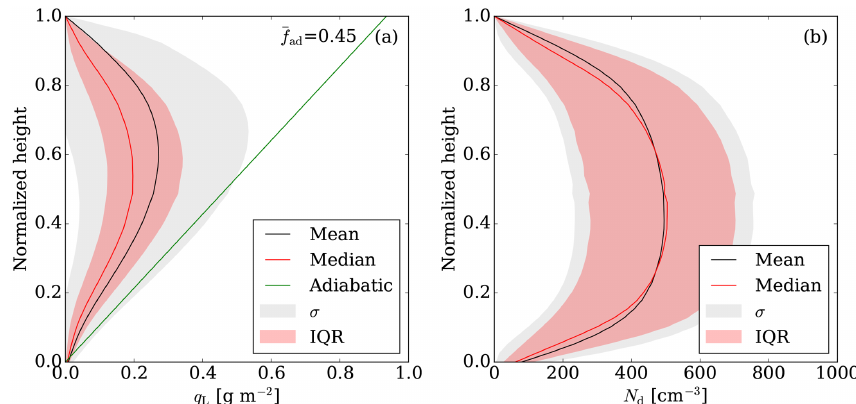
Figure 3. ICON-LEM simulated mean (a) q L and (b) N d profiles for all the case days on average. Profiles are normalized over height from the CBH to the CTH. Black lines denote the mean, solid red lines the median, gray shaded areas the standard deviation, red shaded areas the interquartile range (IQR), and the solid green line outlines the mean adiabatic q L profile characterized by a mean adiabatic fraction ( f ad ) of 0.45.